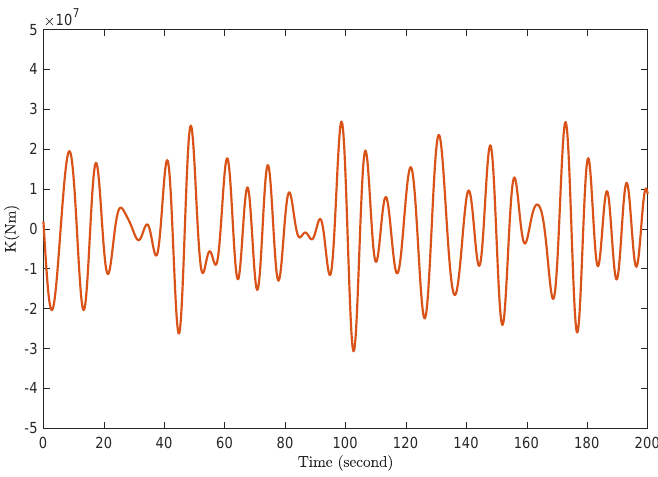
Figure 3. The six-level sea wave momentum.